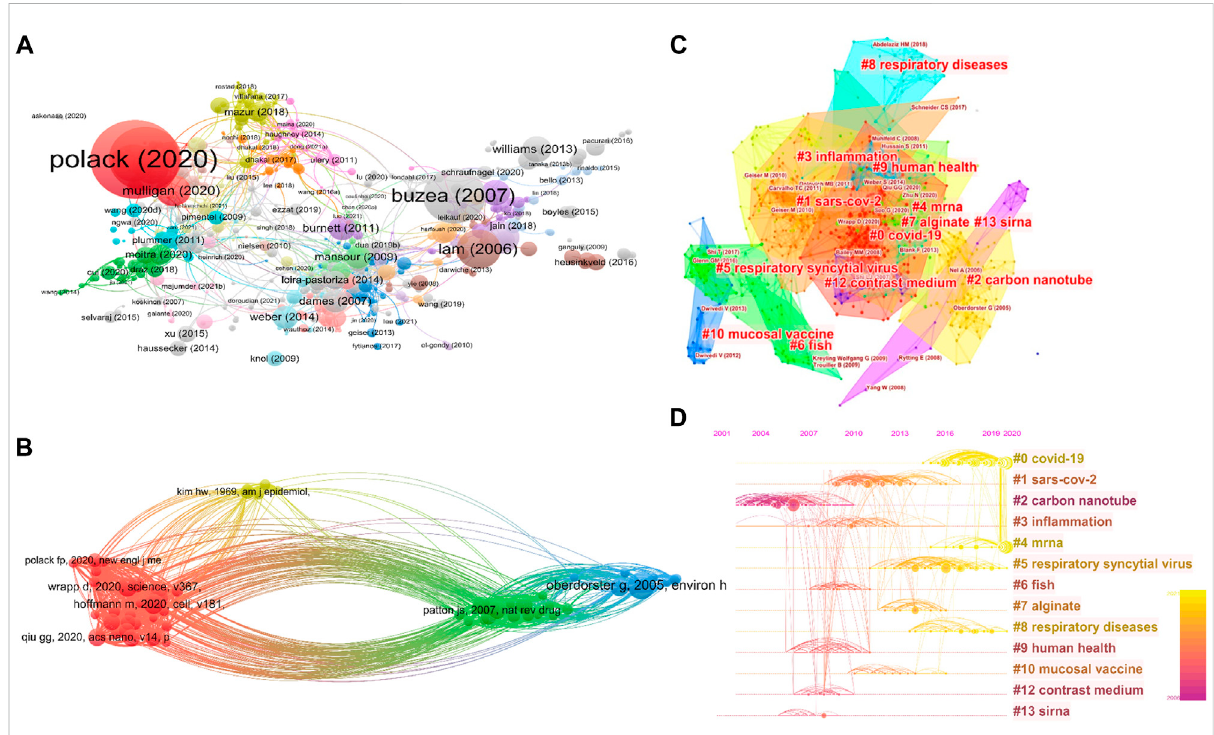
Analysis of the co-cited reference. (A) Visualization graph of cited references. (B) The connection between references. (C) Co-citation references keywords. (D) The timeline of cited